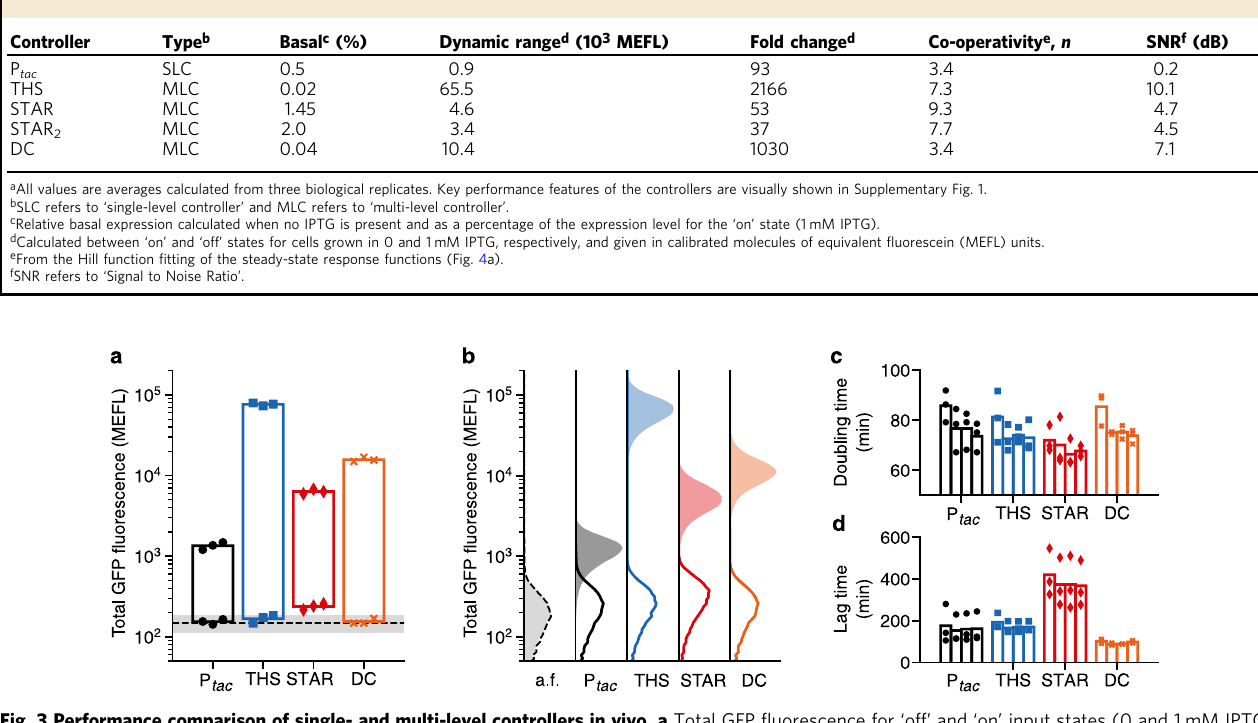
Table 1 Performance summary of the single- and multi-level controllers in vivo a